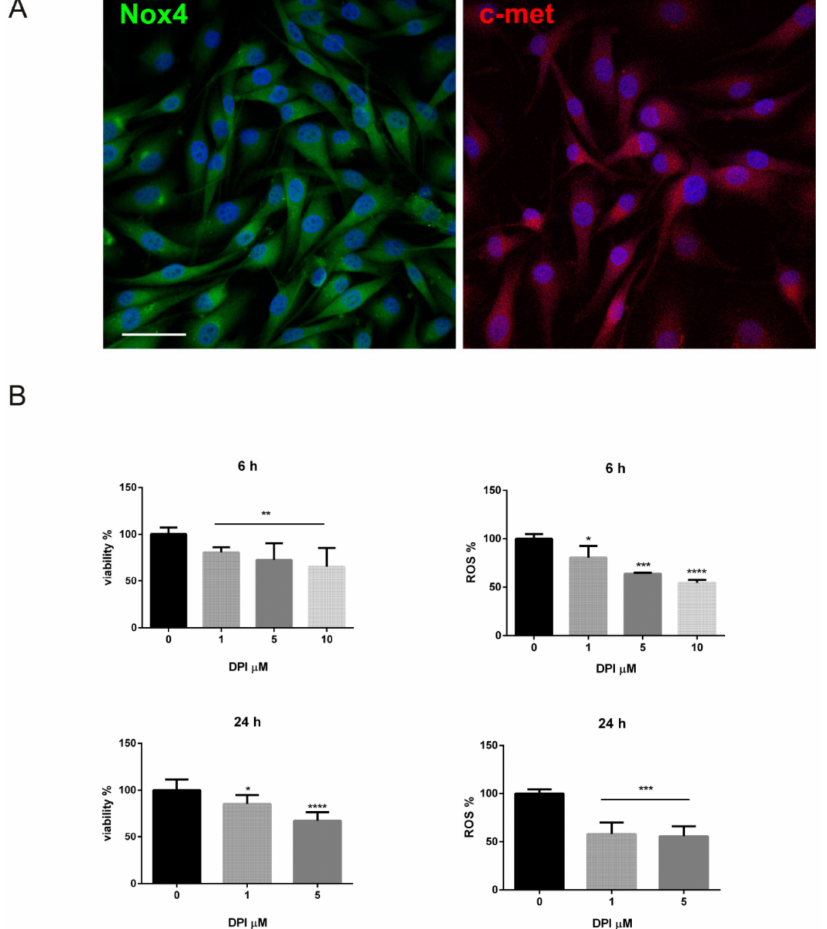
Figure 3. Nox4 and c-met expression in SK-MEL-28 BRAF mutated melanoma cell line. ( A ) Represen- tative images with DAPI (blue), Nox4 (green) or c-met (red) signals of SK-MEL-28. Scale bar = 20 µ m. ( B ) Graphs showing MTT assay and ROS levels measured in SK-MEL-28 cells treated with DPI up to 10 µ M for 6 or 24 h. * p- value < 0.05; ** p- value < 0.01; *** p- value < 0.001; **** p- value <